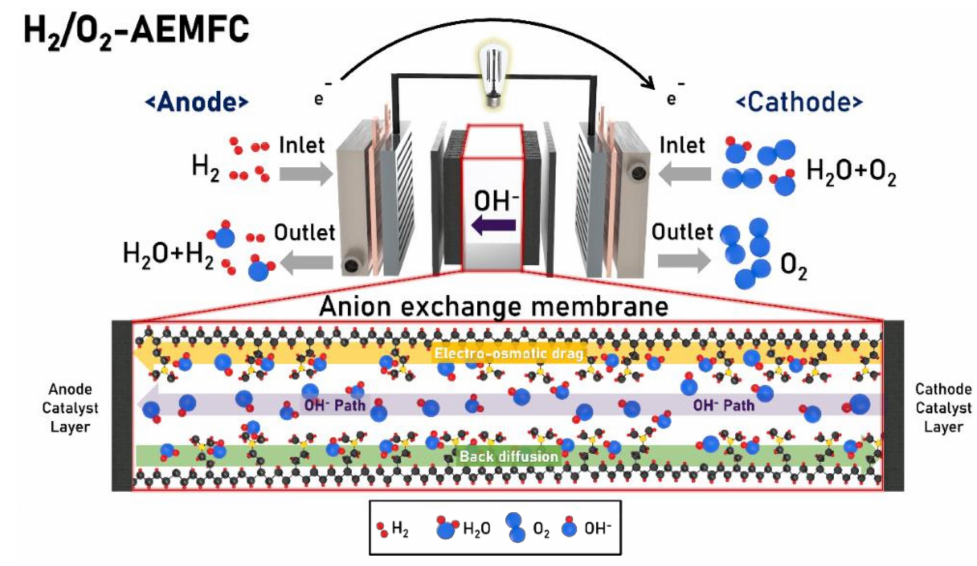
Figure 2. Schematic diagram of the H 2 /O 2 AEMFC.